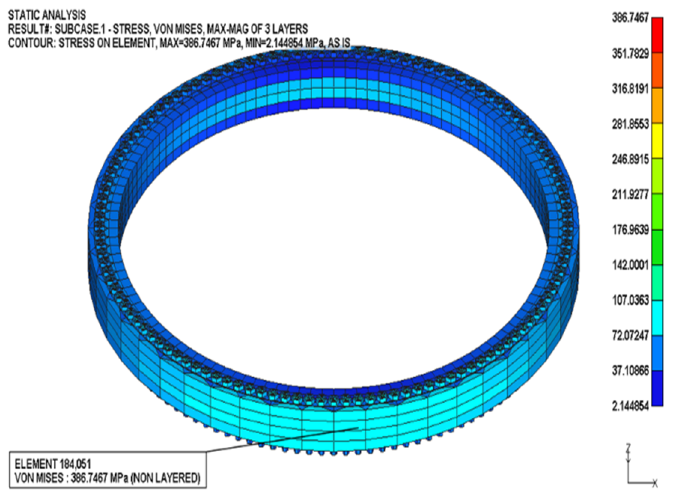
Figure 17. Equivalent stress distribution of bolted joint connection (LC06).